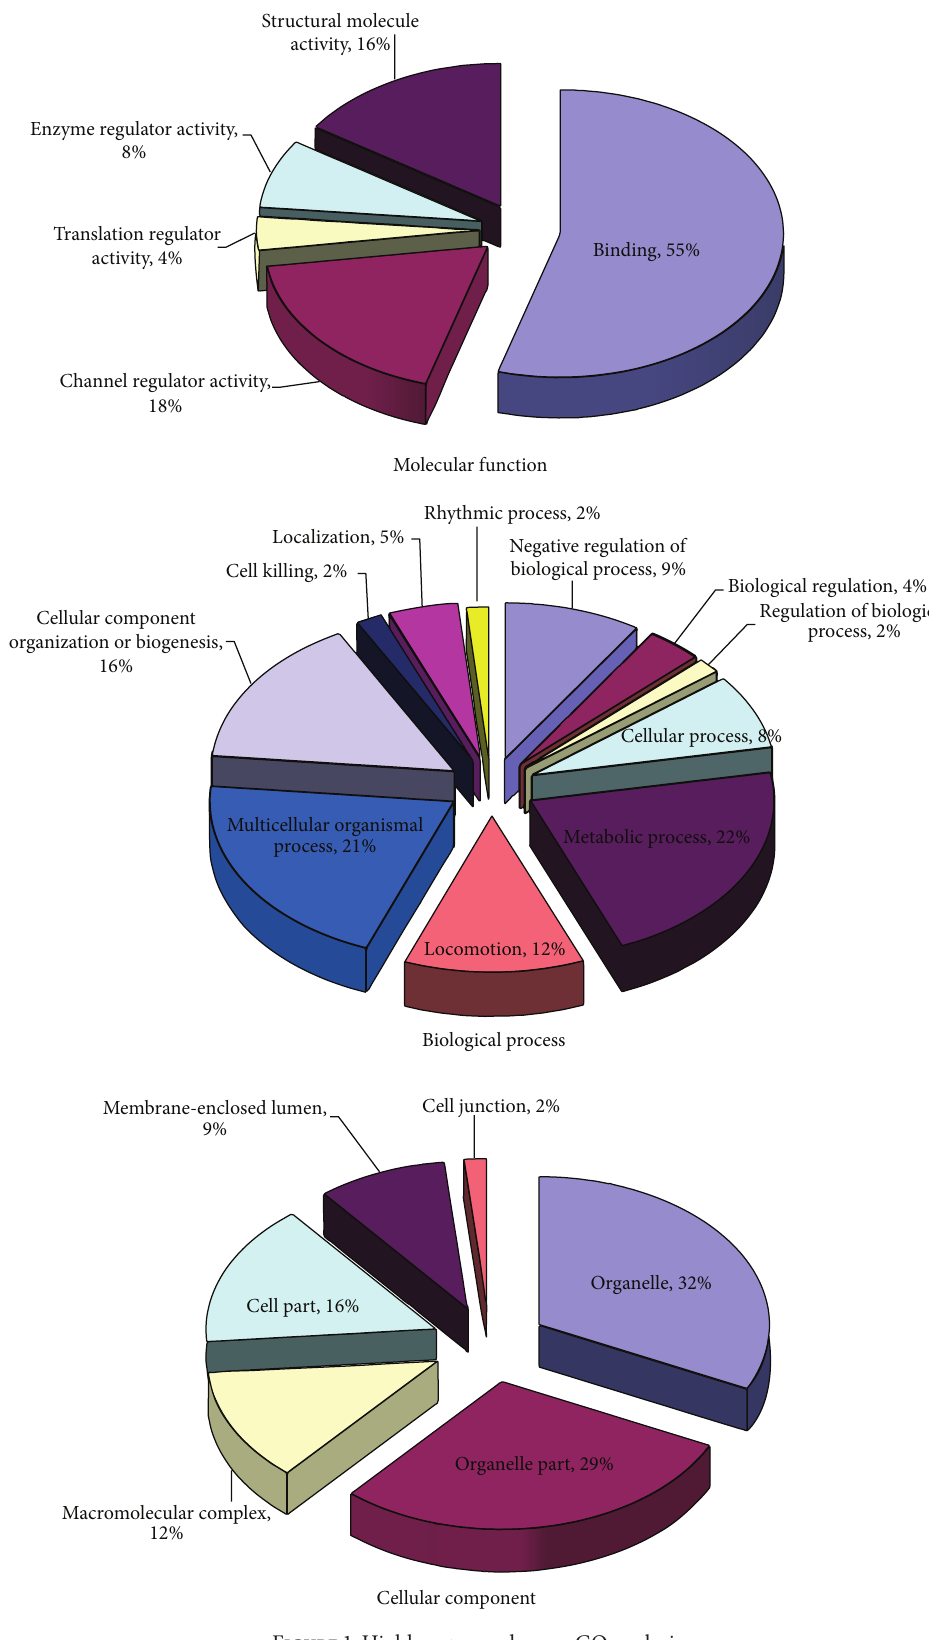
Figure 1: Highly expressed genes GO